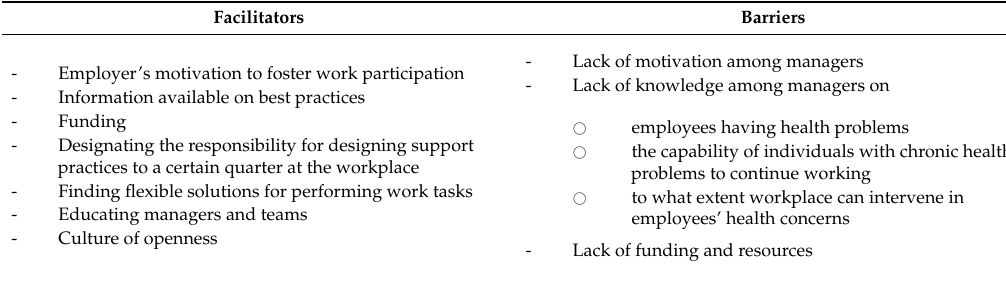
Table 1. Facilitators and barriers in the implementation of interventions facilitating work participation of employees with chronic health